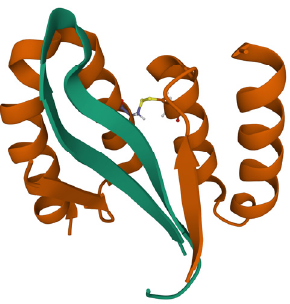
Figure 8. Complex of disulfide-linked dimeric affibody protein ZA β 3 (brown) with A β 40 in β -hairpin conformation (green). PDB ID: 2OTK.